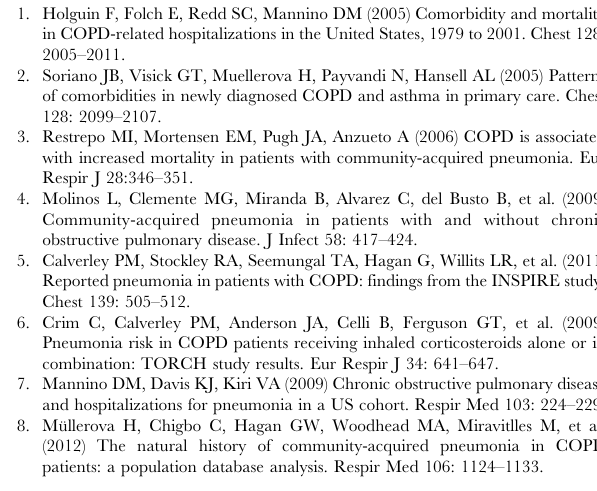
Table S5 Incidence of first pneumonia per 1000 person years for the final analysis cohort before and after propensity score balancing. IR: Incidence rate; PY: person years; Y: years. Severe pneumonia- pneumonia episode due to hospitalization or death during the pneumonia episode not censoring for prior non-severe pneumonia episode(s). Table S6 Hazard ratio and 95% CI of the association between first pneumonia and initiating medication use: applying sensitive to